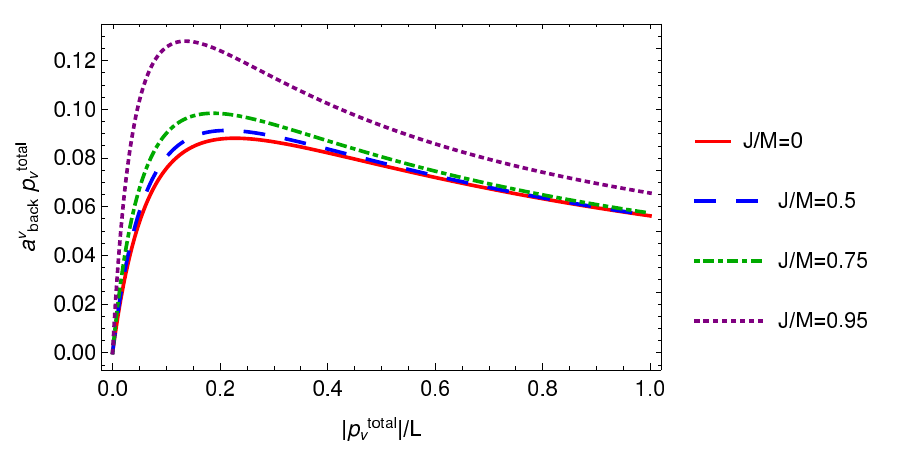
sent spherically distributed v . 2 (cid:25)